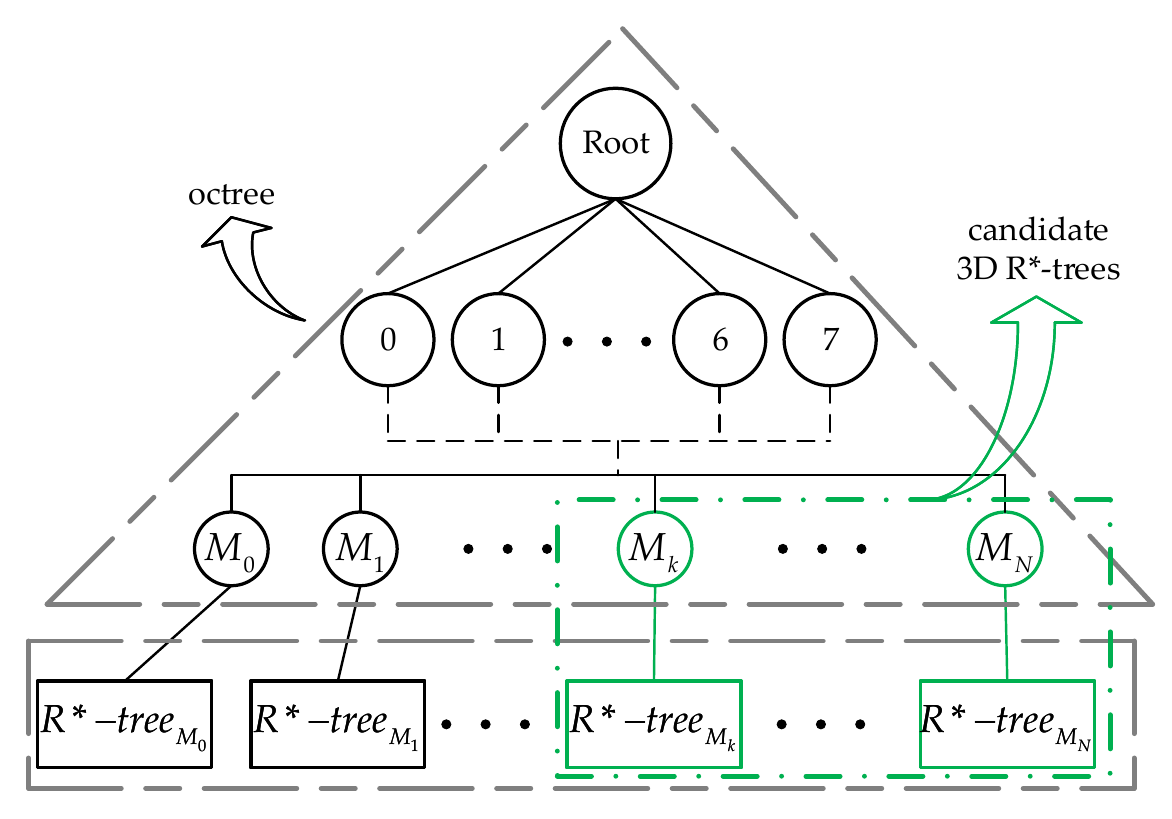
Figure 4. Two-level hybrid